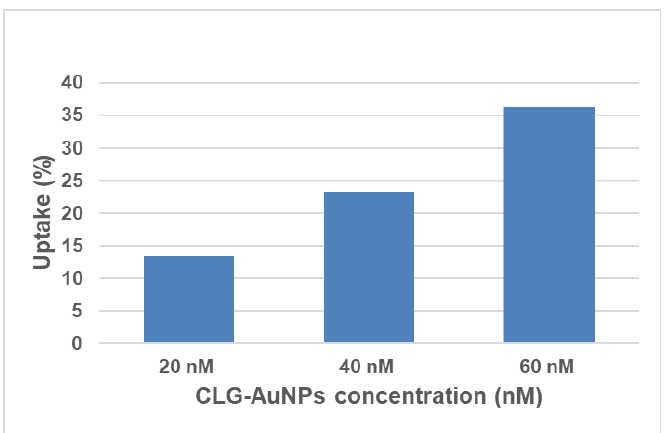
Figure 6. Internalization of clg-AuNPs in HeLa